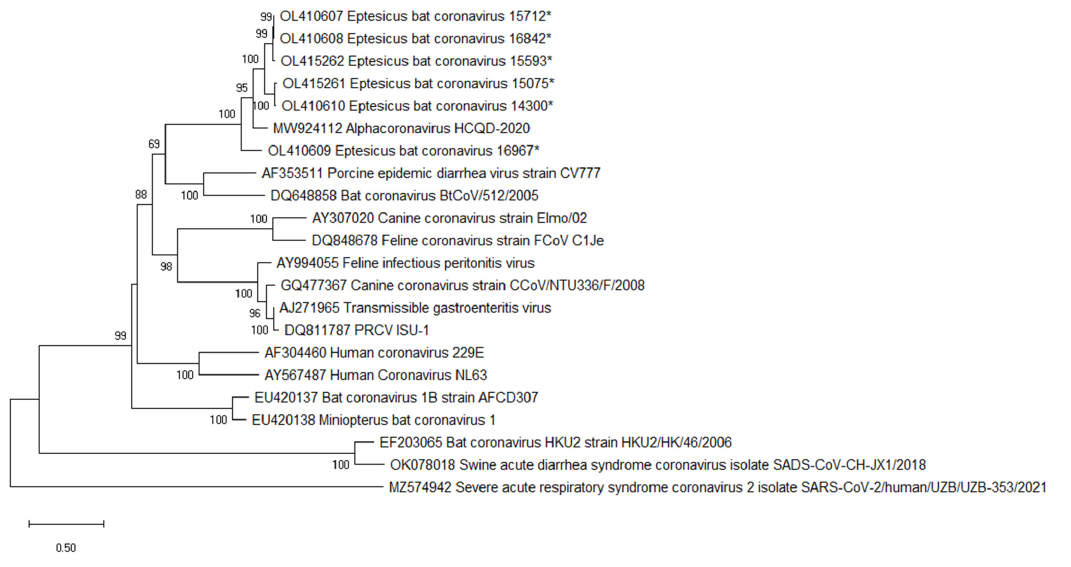
Figure 5. Spike gene sequence phylogenetic tree inferred by MegaX using maximum likelihood methodology and the GTR + G substitution model [21,22]. The bootstrap values are from 1000 replicates. Bootstrap values greater than 68 are shown. Sequences determined here are indicated by *.